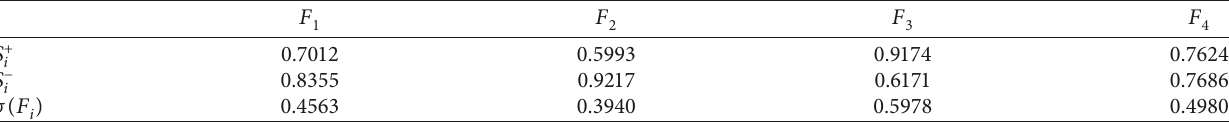
Table 7: Distance measure and accessible degree of positive and negative weighting measures for each